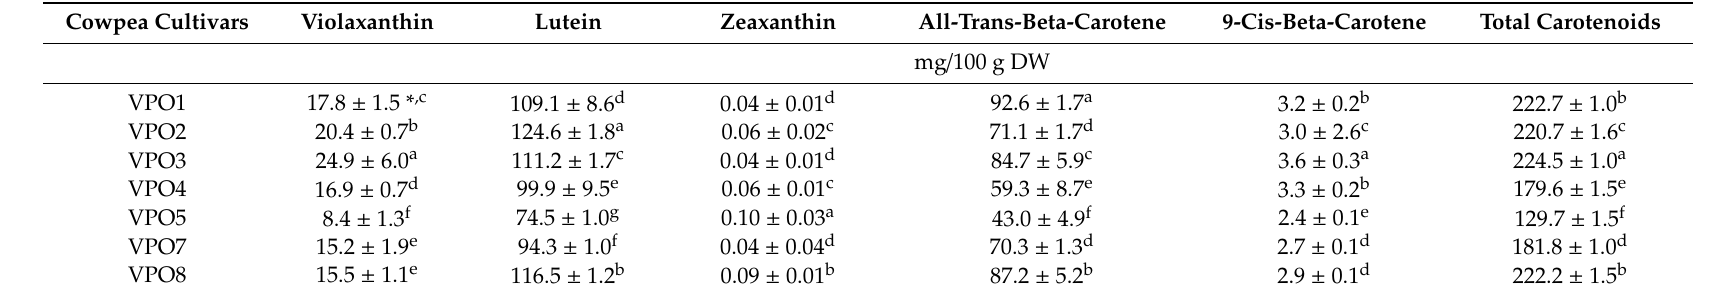
Table 2. Carotenoid content in the leaves of di ff erent cowpea cultivars.